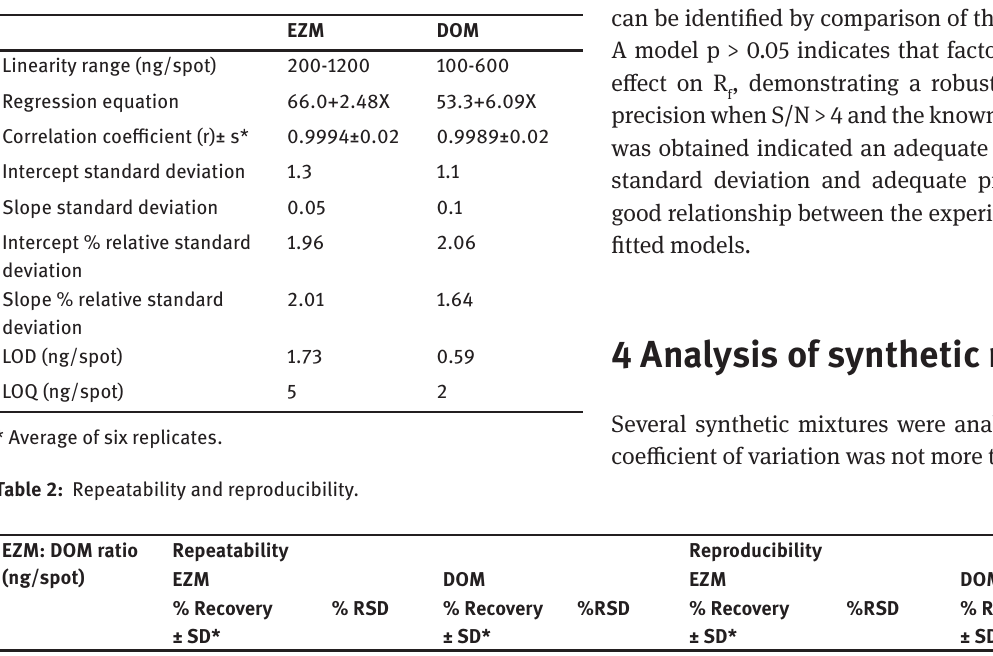
Table 1: UV-spectrodensitometric method.